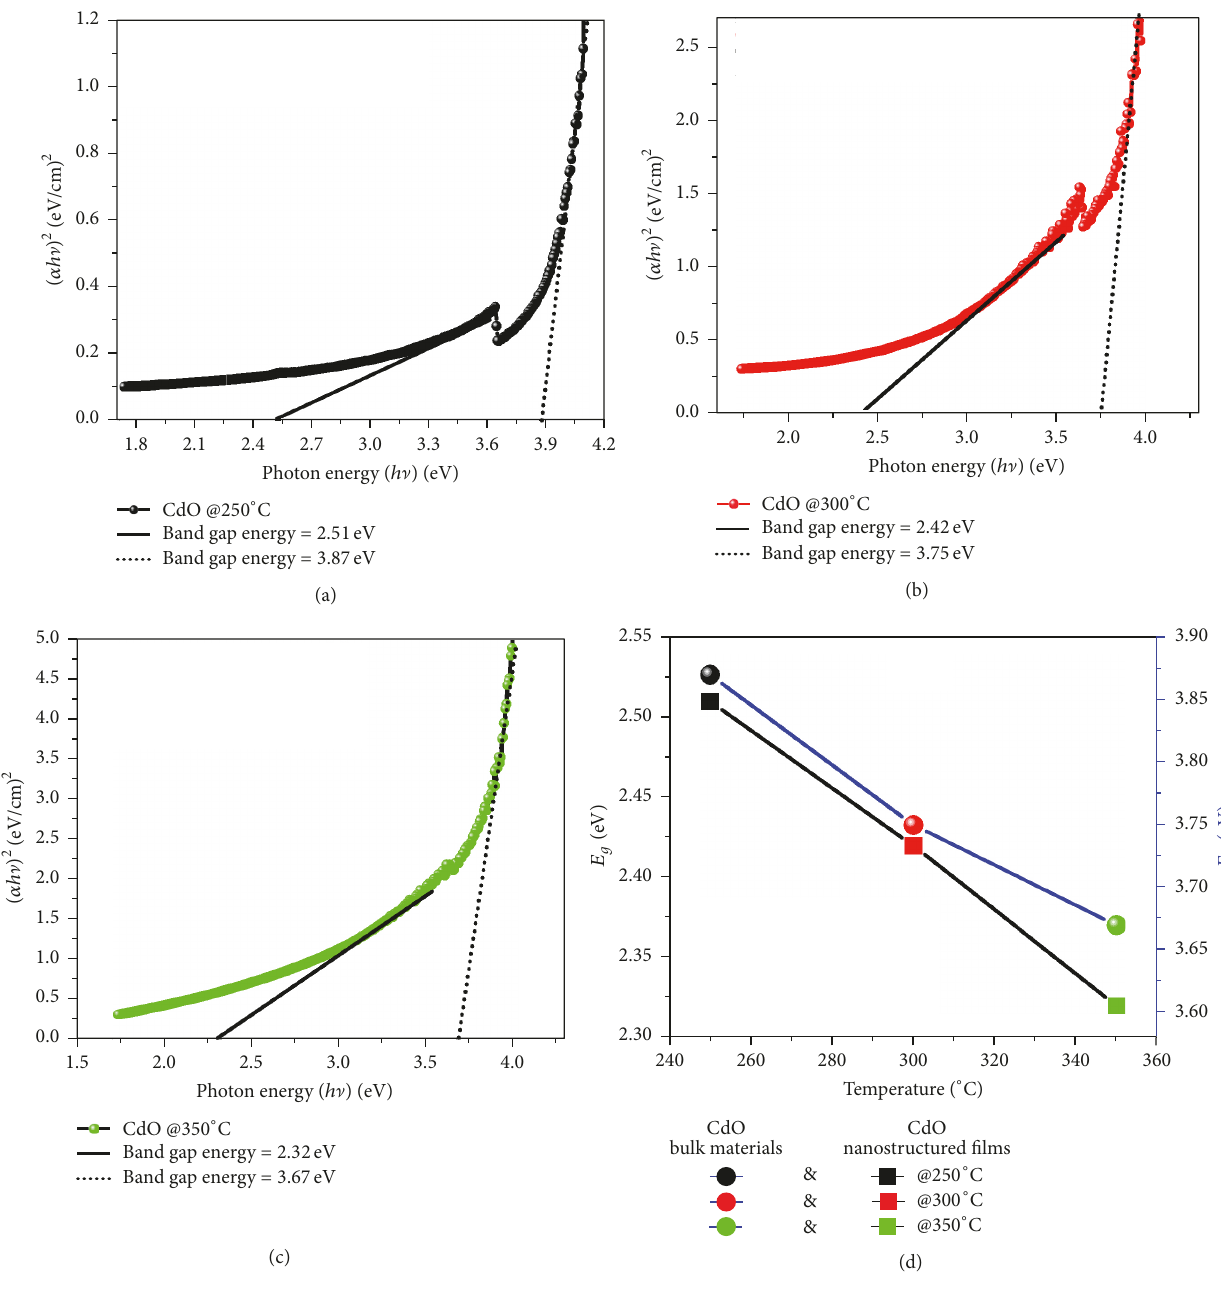
Figure 6: Variation of (𝛼ℎ ] ) 2 versus ℎ ] of the CdO thin films annealed at 250 (a), 300 (b), and 350 ∘ C (c) and the band gap energy (d).